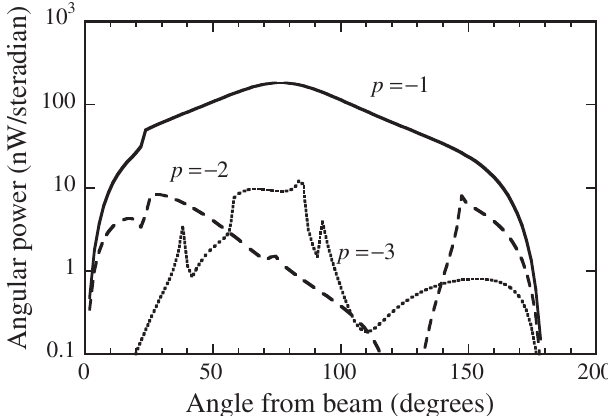
FIG. 5. Angular power of incoherent SP radiation on the first few orders versus angle (cid:3) from the electron beam, at (cid:5) (cid:1) 0